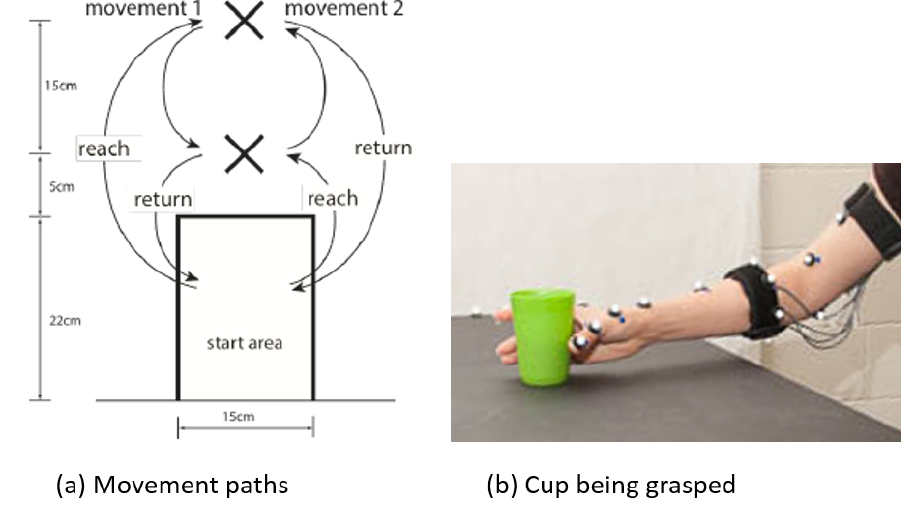
Figure 1. Schematic representation of the task ( a ) and a picture of the cup being grasped, along with the markers and band being used ( b ). Arrows in ( a ) indicate the reach and return for each movement, and “X” symbols mark the object locations. ( a ) reproduced with permission from Beckers et al.